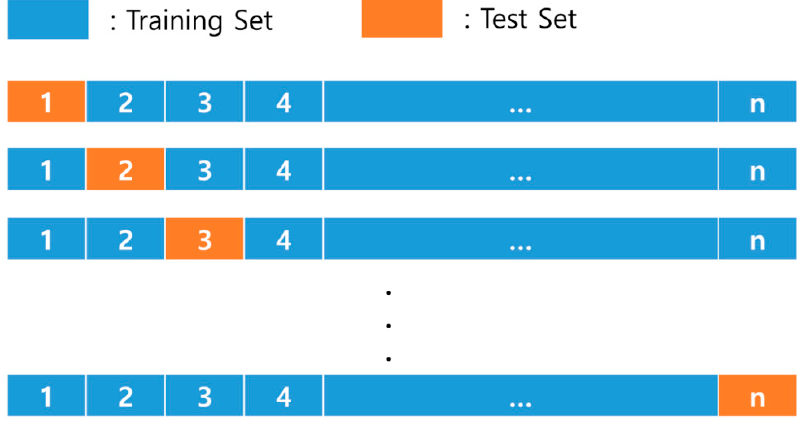
Figure 2. Schematic representation of the leave-one-out cross-validation (LOOCV) method .